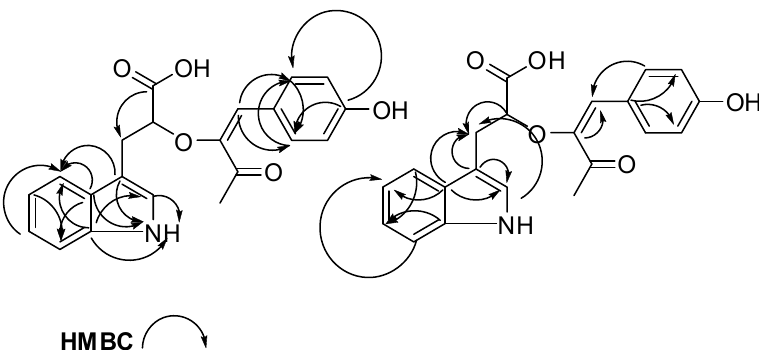
Figure 2. Key COSY and TOCSY correlations (bold lines) show all the spin systems present in compound 1 .